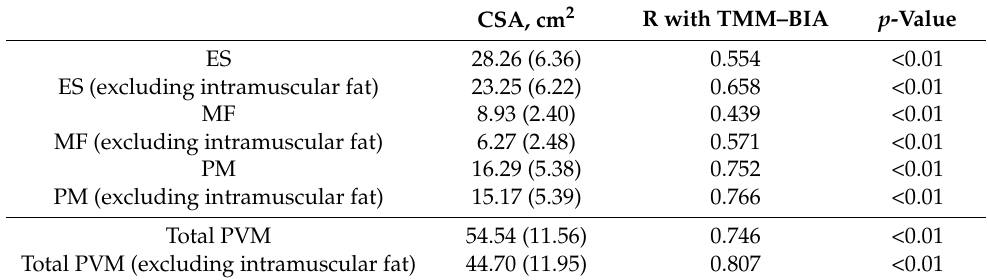
Table 2. Correlations between TMM–BIA and each PVM with and without intramuscular fat.